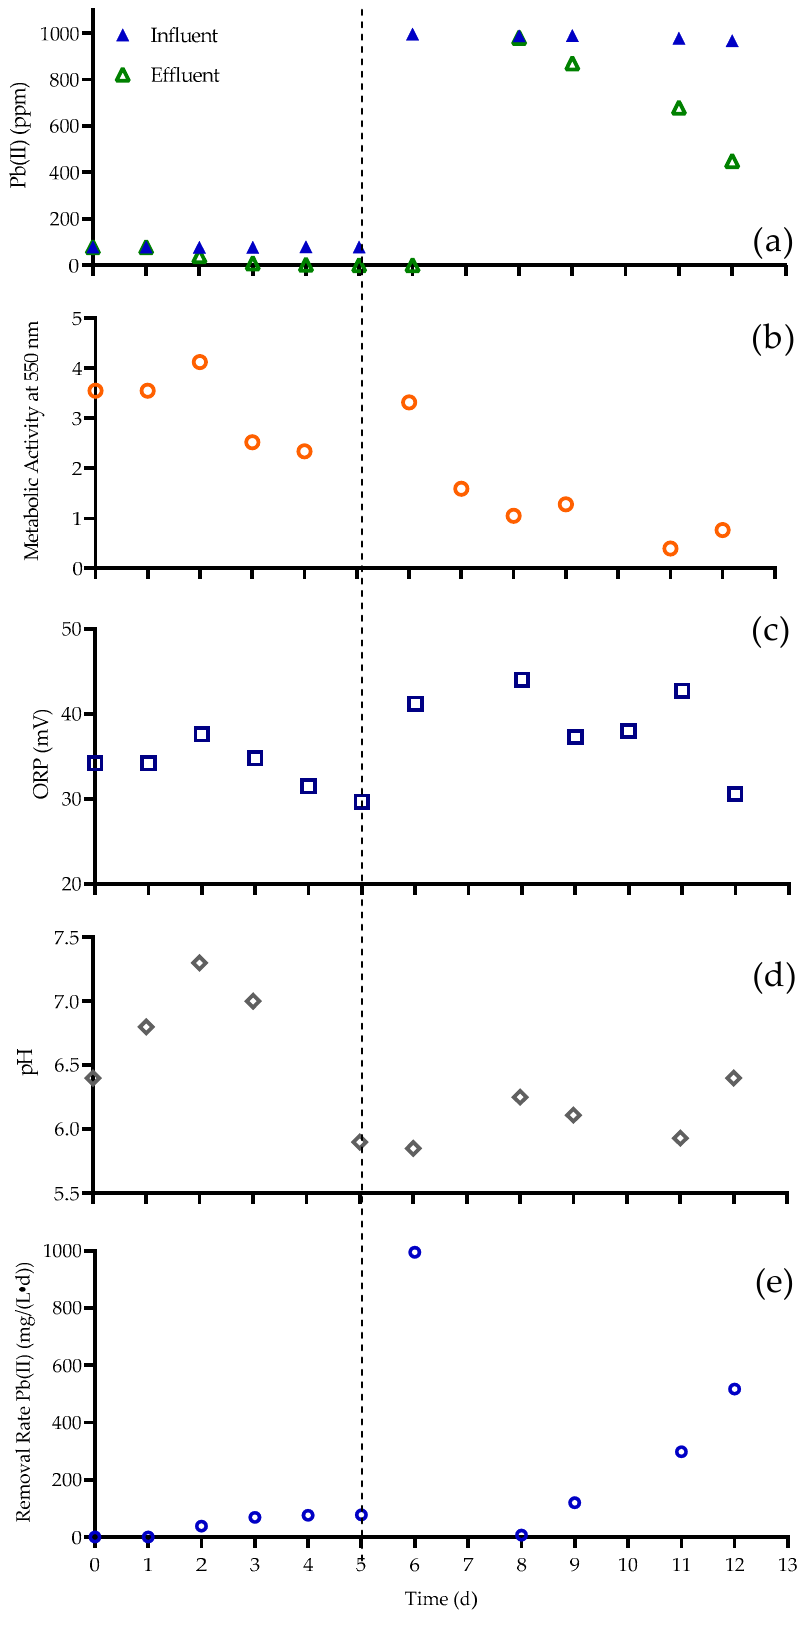
Figure 2. The lead level ( a ), metabolic activity ( b ), ORP ( c ), pH ( d ) and Pb(II) removal rate ( e ) over time for run 1.